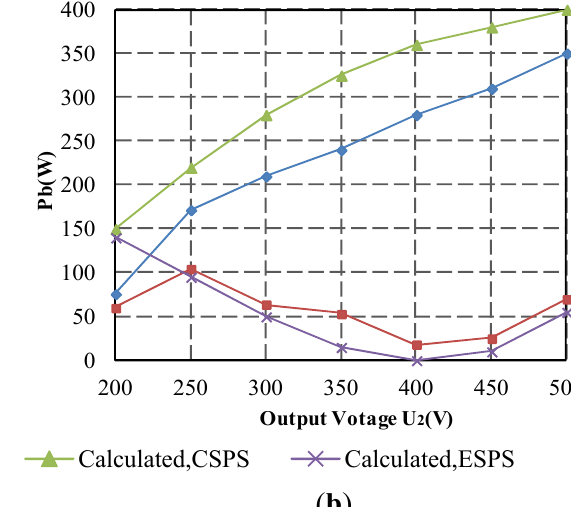
Figure 13. Curves of the current stress and reactive power varied with d in ESPS and CSPS control. ( a ) Peak current; ( b ) Backflow power.